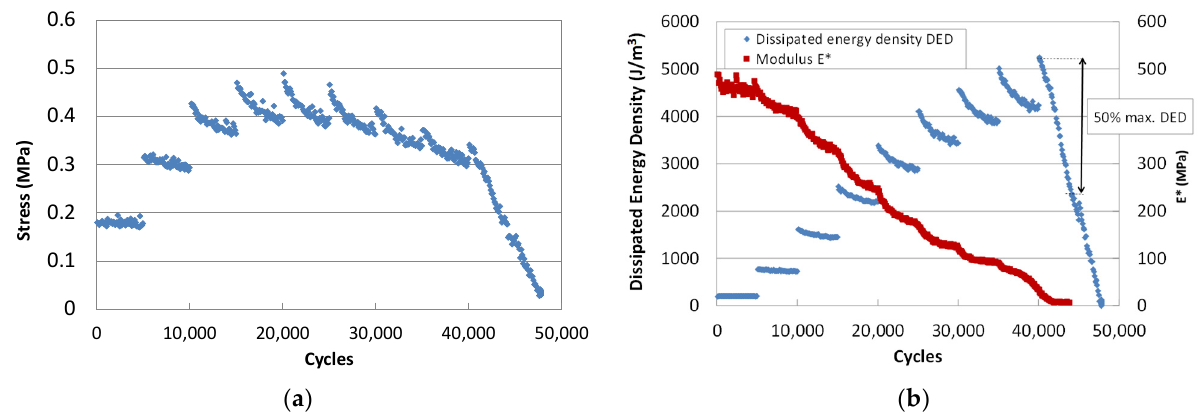
Figure 2. EBADE tests set up for ( a ) prismatic asphalt mixture and ( b ) cylindrical asphalt bitumen specimens.